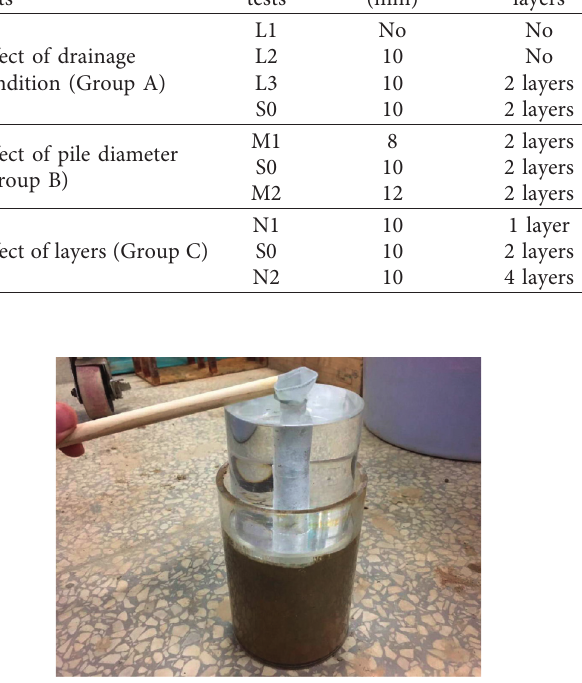
Figure 4: Set up of soil column with (drained) timber bolt before loading.